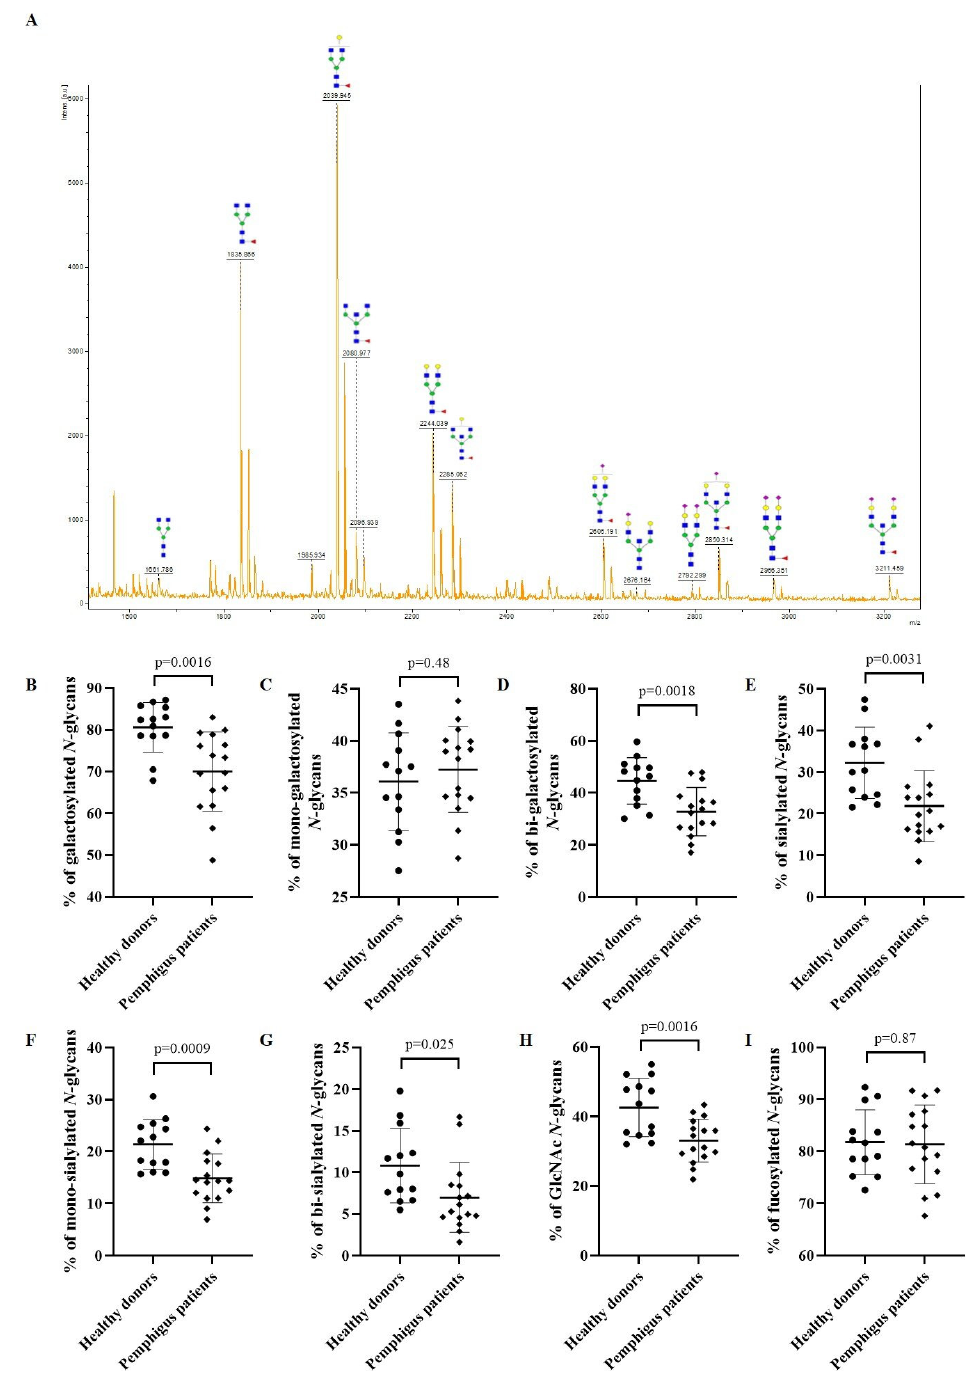
Figure 2. The N- glycan profile of pemphigus patients before rituximab treatment (at baseline) compared to healthy donors. MALDI-TOF mass spectra of total IgG N- glycans from pemphigus patients ( A ). The N -glycan structures were drawn according to the international nomenclature [25]. Blue square: N -acetylglucosamine; green circle: mannose; yellow circle: galactose; purple diamond: N -acetylneuraminic acid; red triangle: fucose. The percentage based on the relative quantification of galactosylated ( B ), mono-galactosylated ( C ), bi-galactosylated ( D ), sialylated ( E ), mono- sialylated ( F ), bi-sialylated ( G ), N -acetylglucosamine (GlcNAc) ( H ), fucosylated ( I ) N -glycans from IgG. Differences were considered significant when p cor. < 0.006 with Bonferroni